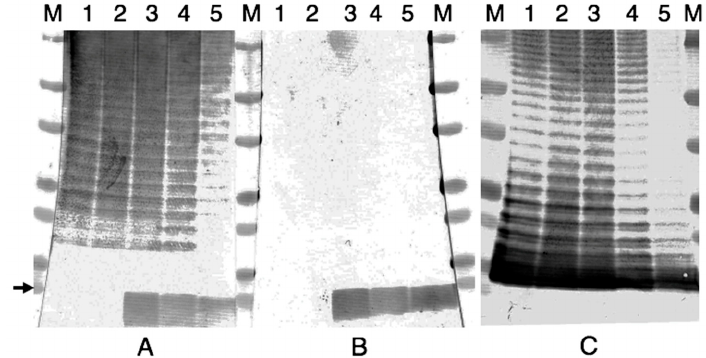
Figure 9. Antigenic change in lipopolysaccharide (LPS) of KU-1 variants passaged on Eugon chocolate agar in Western blots. Purified LPSs of KU-1 original and the variants passaged on Eugon chocolate agar 10, 20, and 80 times (EP10, EP20, and EP80, respectively) and LVS (lanes 1, 2, 3, 4, and 5, respectively) were detected using MAbs M15C6, M13A13, and FB11 [sheets ( A ), ( B ), and ( C ), respectively]. M: molecular weight markers (Bio-Rad) indicate 75, 50, 37, 25, 20, 15, and 10 (arrow) kDa from the top.